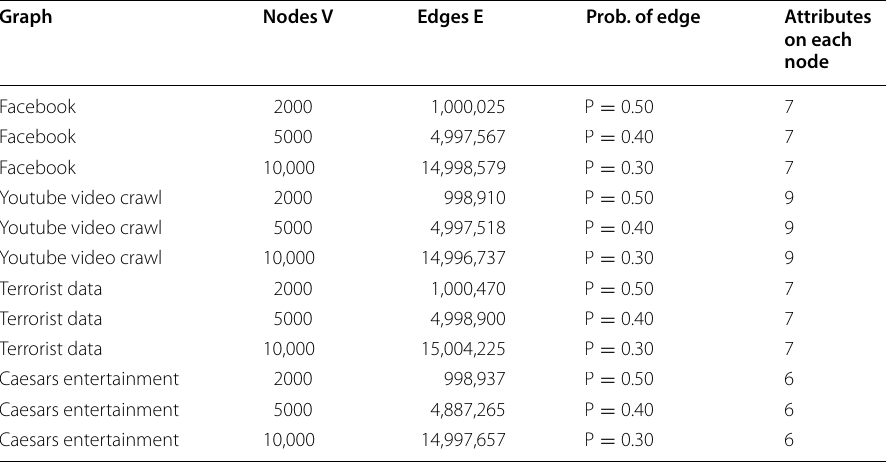
Table 8 Large graph